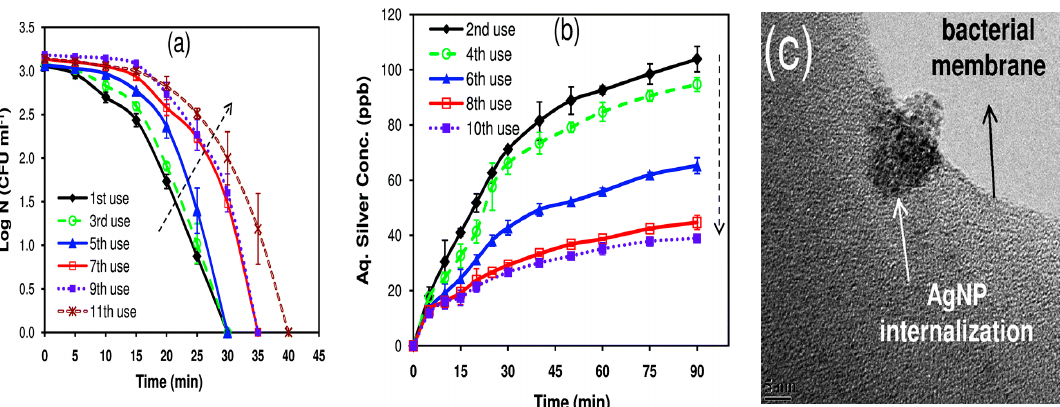
Figure 31. ( a ) Disinfection performance of AgNPs/ZnO nanorods after reusing for 11 runs against E. coli (10 3 CFU/mL). ( b ) The corresponding released silver ions vs time profiles after every usage. ( c ) TEM image showing internalization of AgNP by E. coli . Reproduced from [235] under a Creative Commons Attribution 3.0 Unported